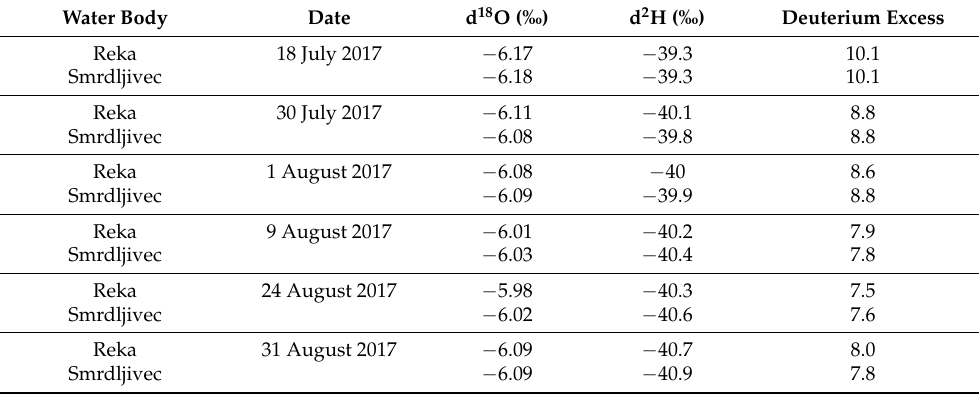
Table 1. Results of stable isotope